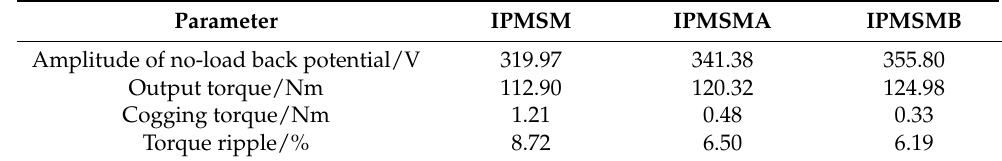
Table 4. Performance comparison of three kinds of motors under rated conditions.